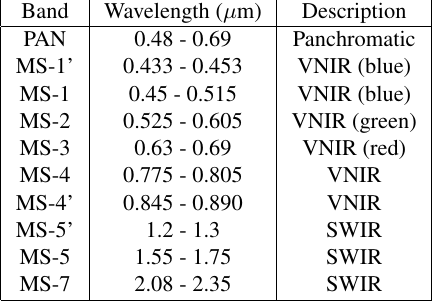
Table 2: Spectral characteristics for the ALI bands used to simulate the pseudo-hyperspectral data for comparison with the one simulated from ALI. The spectral characteristics of ALI bands are summarized in Table 2. In the VNIR and SWIR spectral ranges, ALI image consists 9 multispectral bands versus 6 bands of ETM+ image (except for the panchromatic band). All images are cloud-free and located in an area lying on the border of California and Nevada in US (path 41 and row 34).